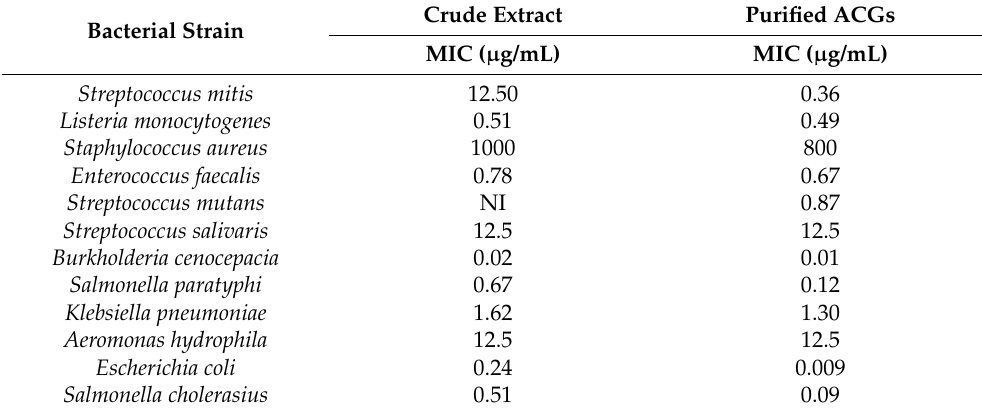
Table 3. Antibacterial activity of crude extract and purified acetogenins on several bacterial strains. Crude Bacterial Strain